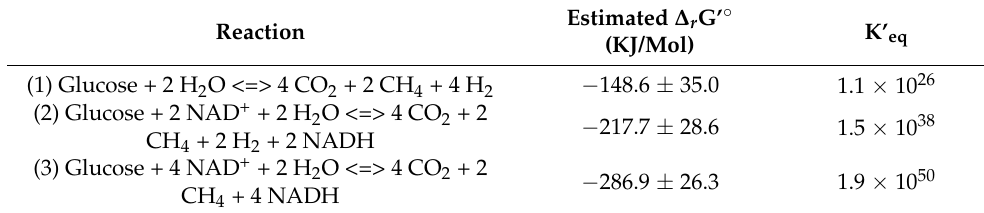
Table 1. Stoichiometric description of the reactions occurring during anaerobic digestion from glucose to acetate, via propionate (1) or butyrate (2) production, or direct fermentation to acetate (3), with kinetic parameters of such